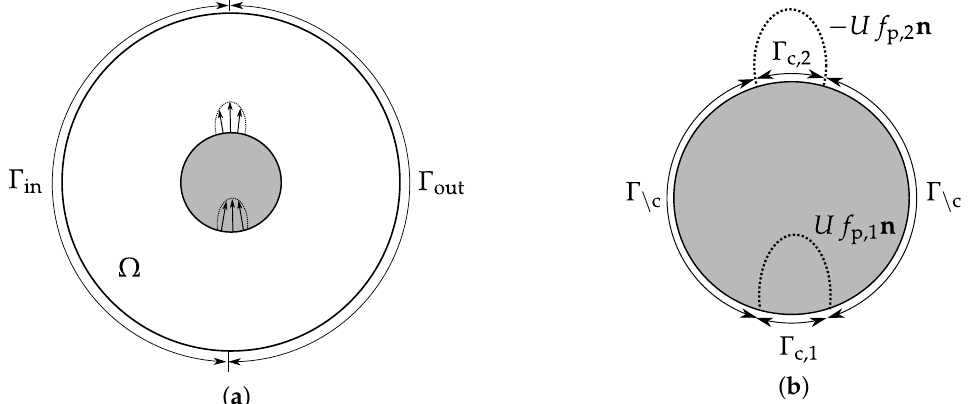
Figure 2. Geometry of flow around a cylinder. ( a ): an overall view, ( b ): an enlarged